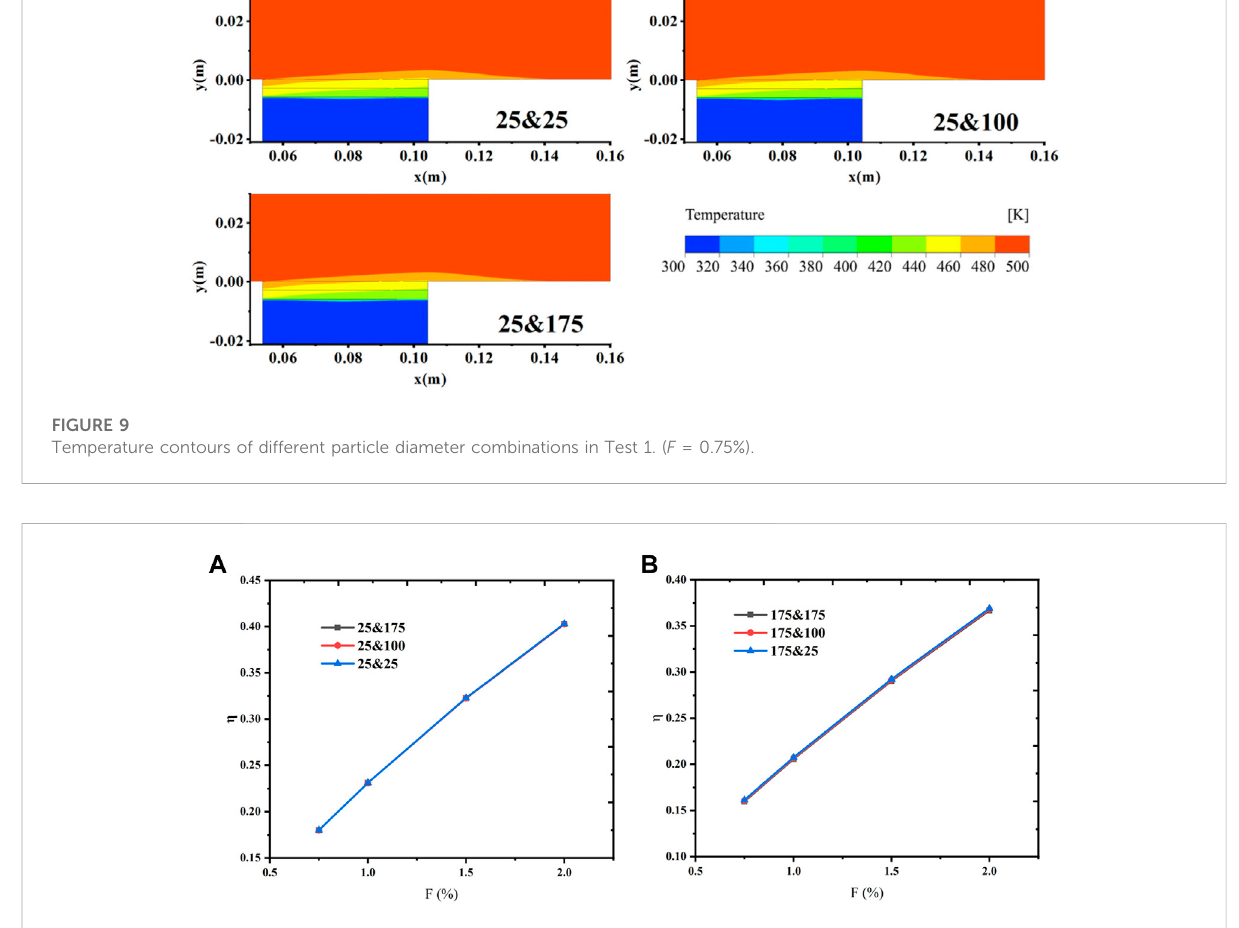
FIGURE 10 Comparison of cooling ef fi ciency for various injection rates. (A) Test 1 and (B) Test